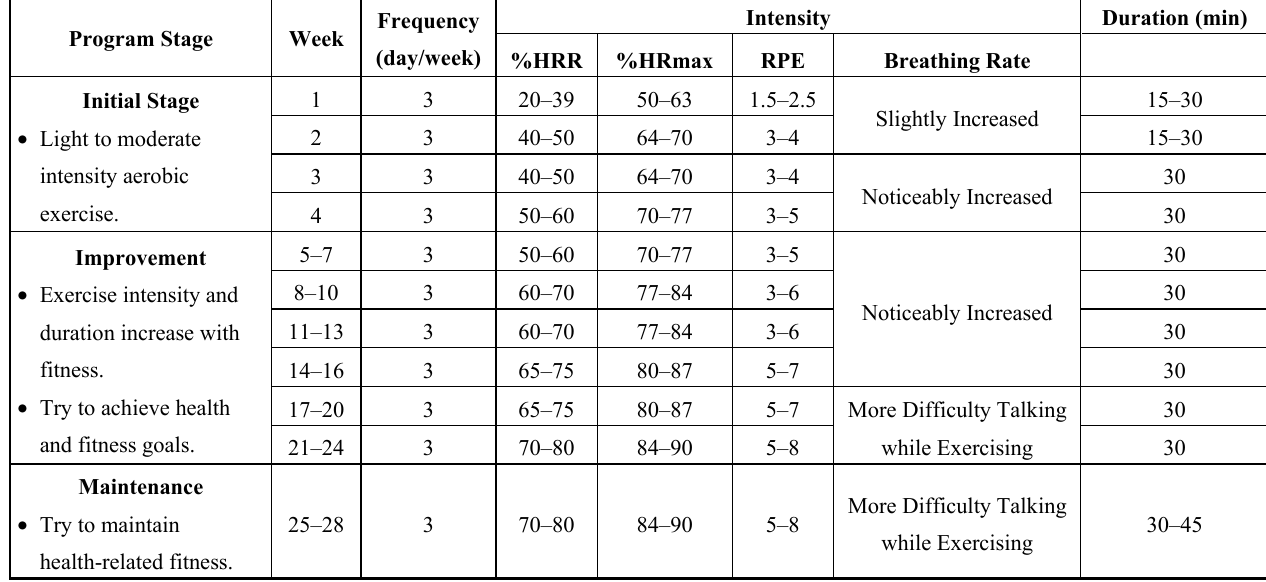
Table 2. Example aerobic prescription for a person living with schizophrenia. Adapted from